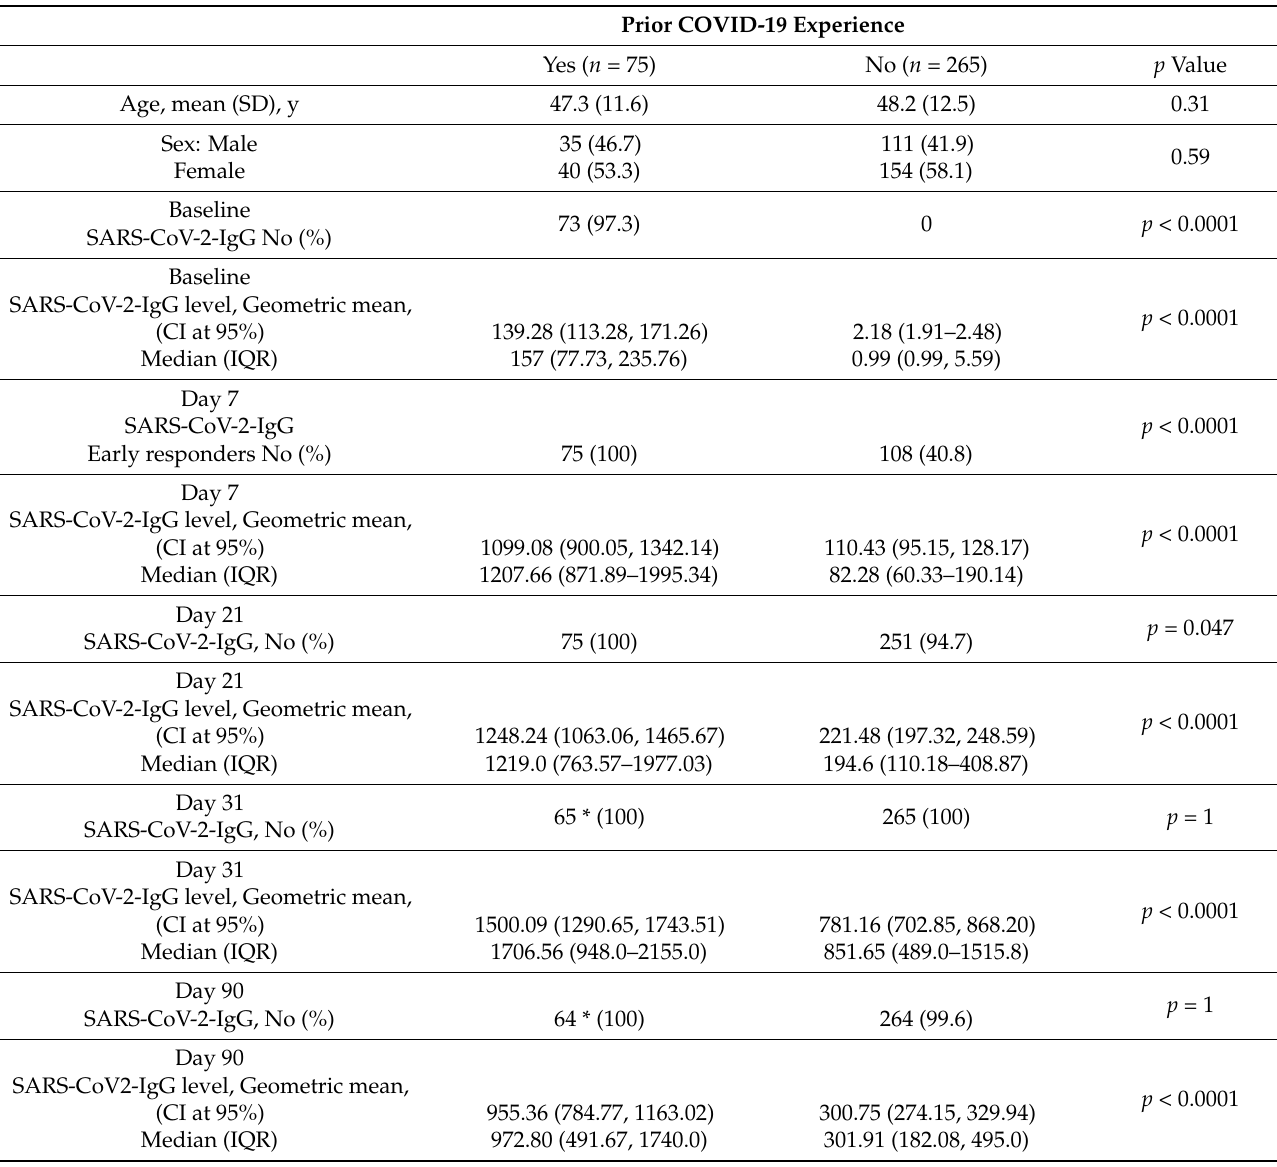
Table 1. Demographic characteristics, percentage of positive and titers of anti-S1 protein at the selected time points by prior COVID-19